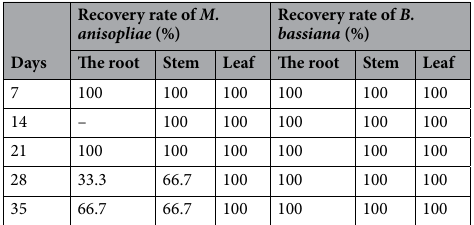
Table 5. Recovery rate of B. bassiana and M. anisopliae f rom maize tissues by PCR amplification.